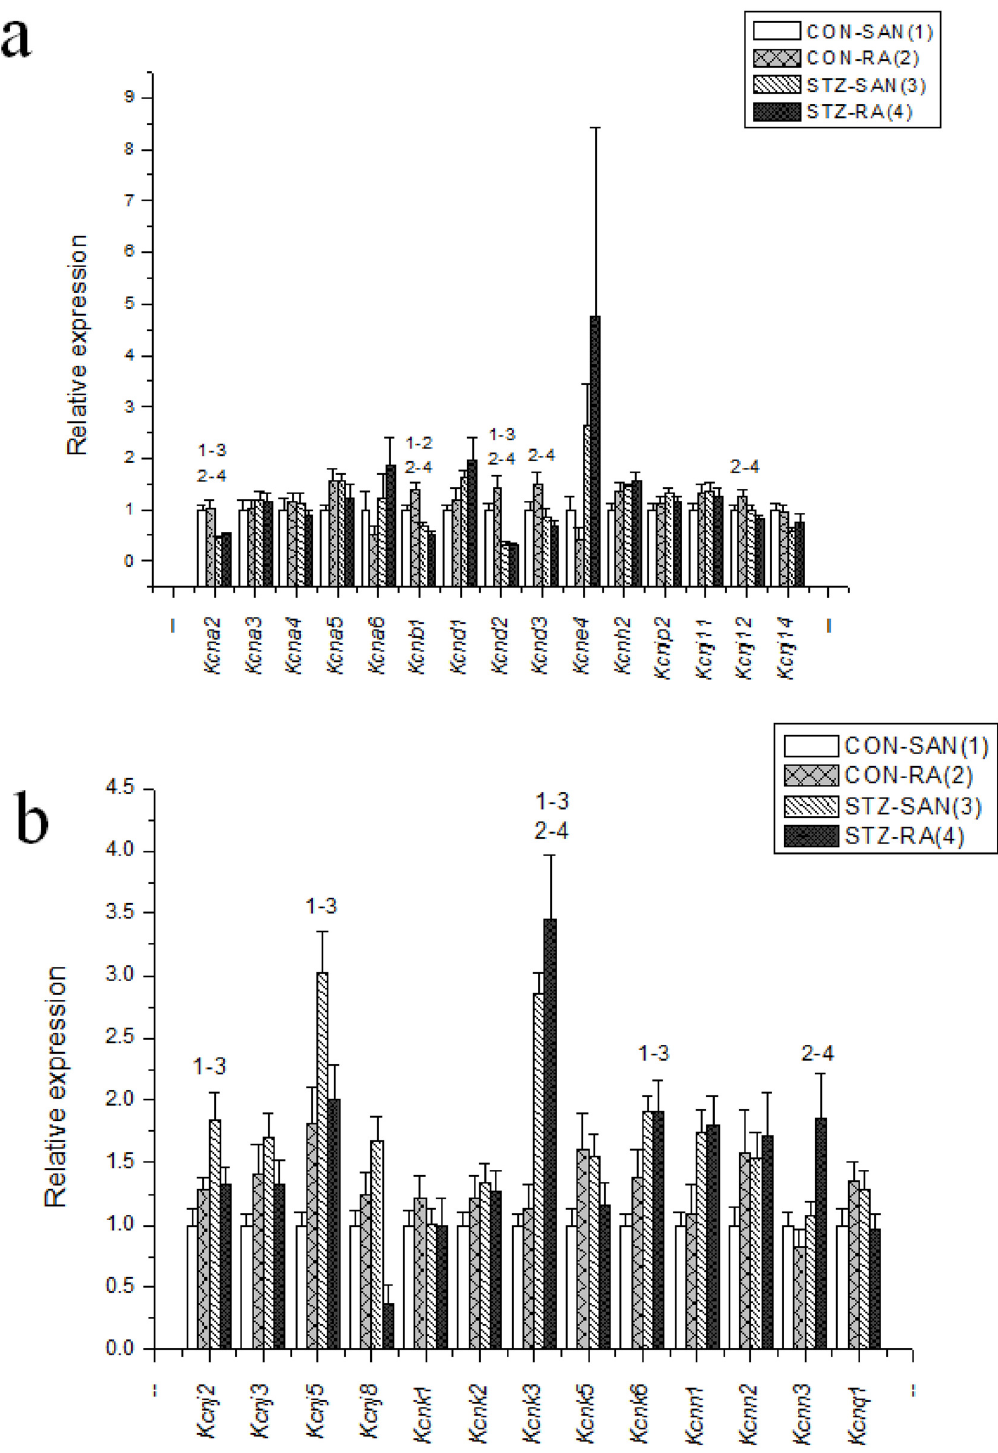
Fig 9. a and b — Expression of genes encoding various potassium channel proteins. Data are mean ± SEM, n = 6 – 10 samples from STZ and control rat each containing SANs from 2 hearts.